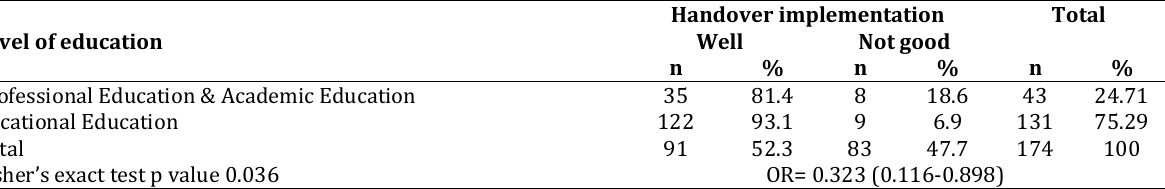
Table 2. Relationship between education level and the handover implementation of nurses in the inpatient ward of Ulin Hospital